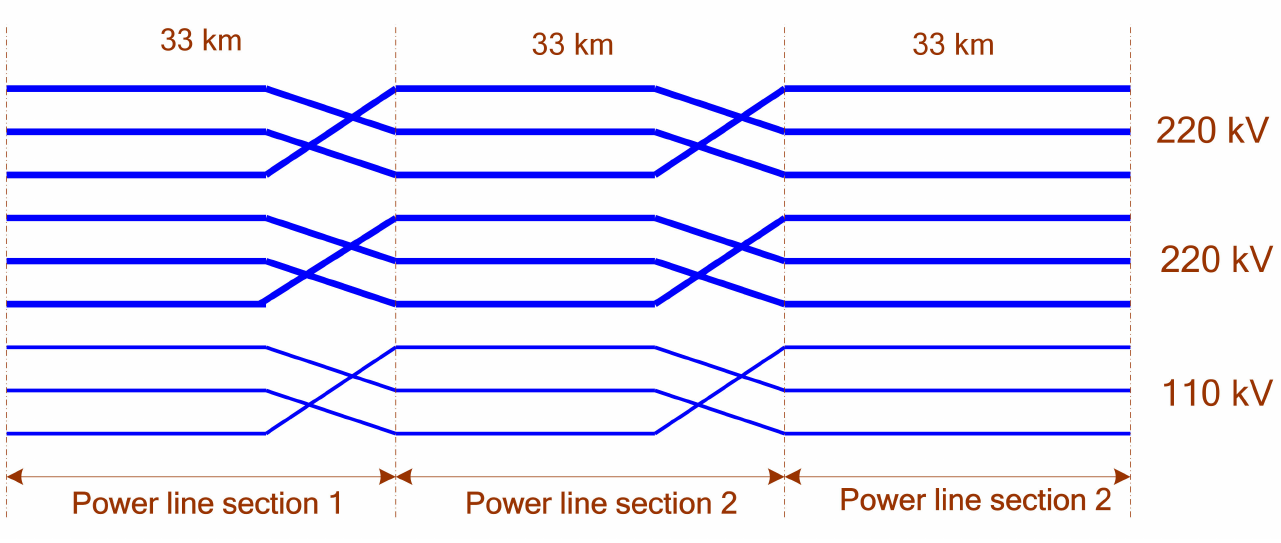
Figure 10. Transmission line transposition